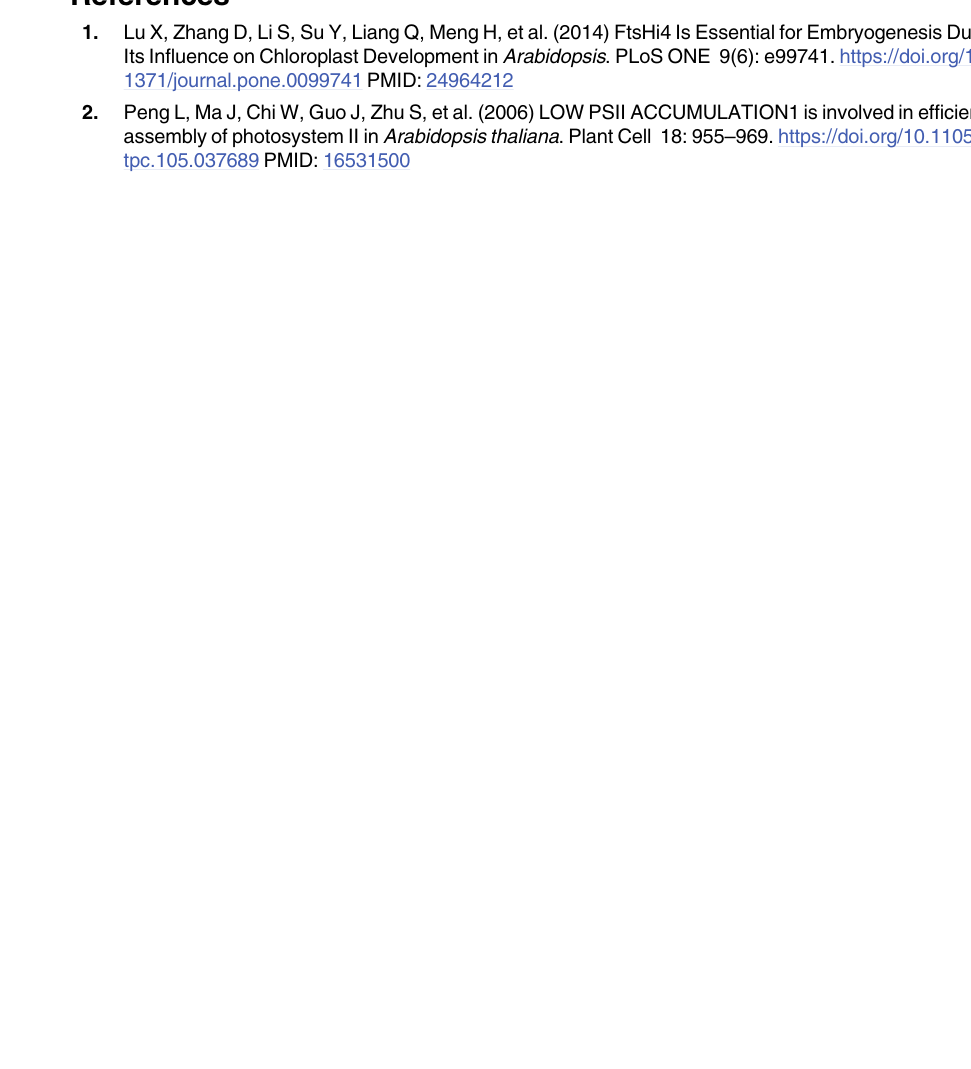
S1 File. Original image for the D1 western blot in Fig 7B. (TIF) S2 File. Original image for the D2 western blot in Fig 7B. (TIF) S3 File. Original image for the Cp43 western blot in Fig 7B. (TIF) S4 File. Original image for the Cp47 western blot in Fig 7B. (TIF) S5 File. Original image for the PsbO western blot in Fig 7B. (TIF) S6 File. Original image for the Cyt f western blot in Fig 7B.